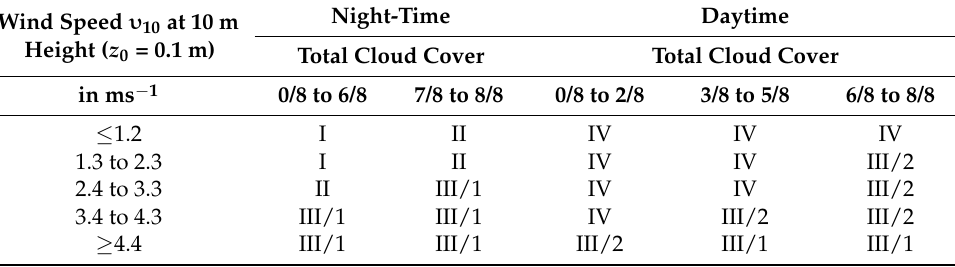
Table 2. VDI scheme to determine Klug/Manier stability classes via cloudiness data (taken from [5]). Wind Speed υ 10 at 10